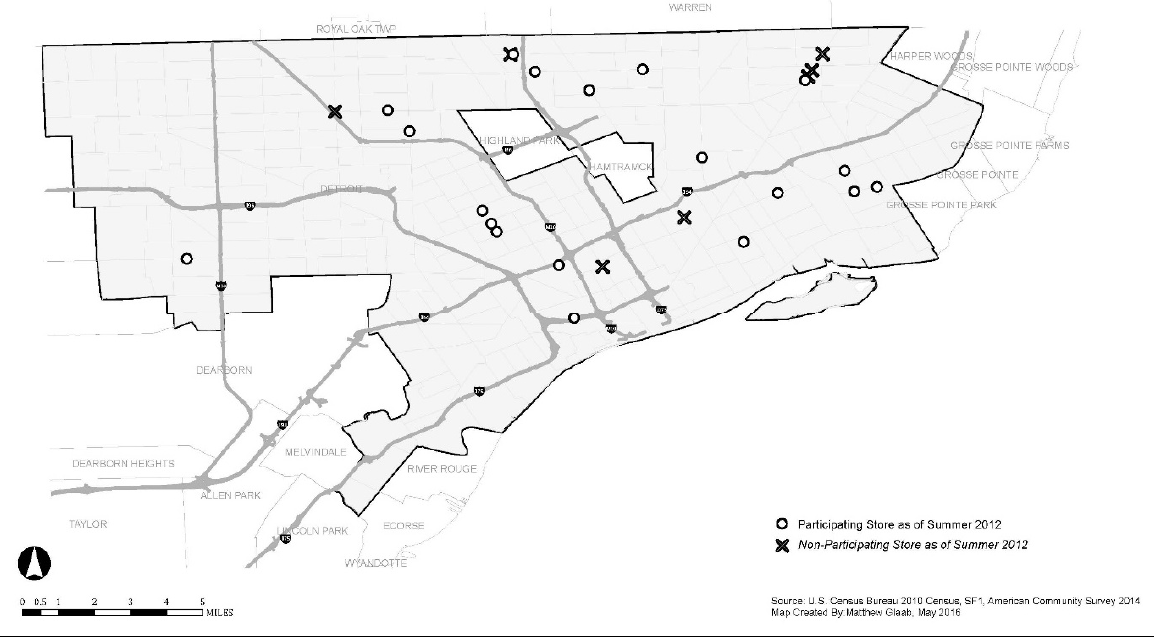
Table 1. Store Performance Relative to Population Loss Between 2000 and 2010 in Zip Codes Relative to the City as a Whole, N =26 Rate of population loss (2000– 2010) in the zip code relative to